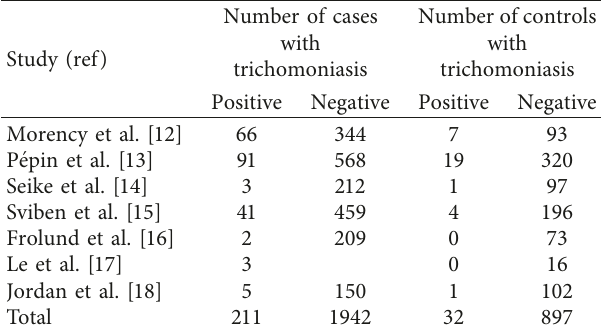
Table 2: The number of cases and control groups with